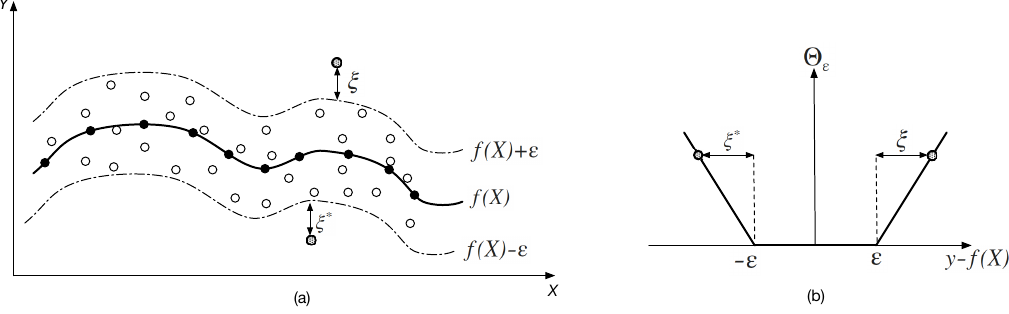
Figure 1. Schematic diagram; ( a ) support vector regression (SVR), and ( b ) SVR using an ε -insensitive function.